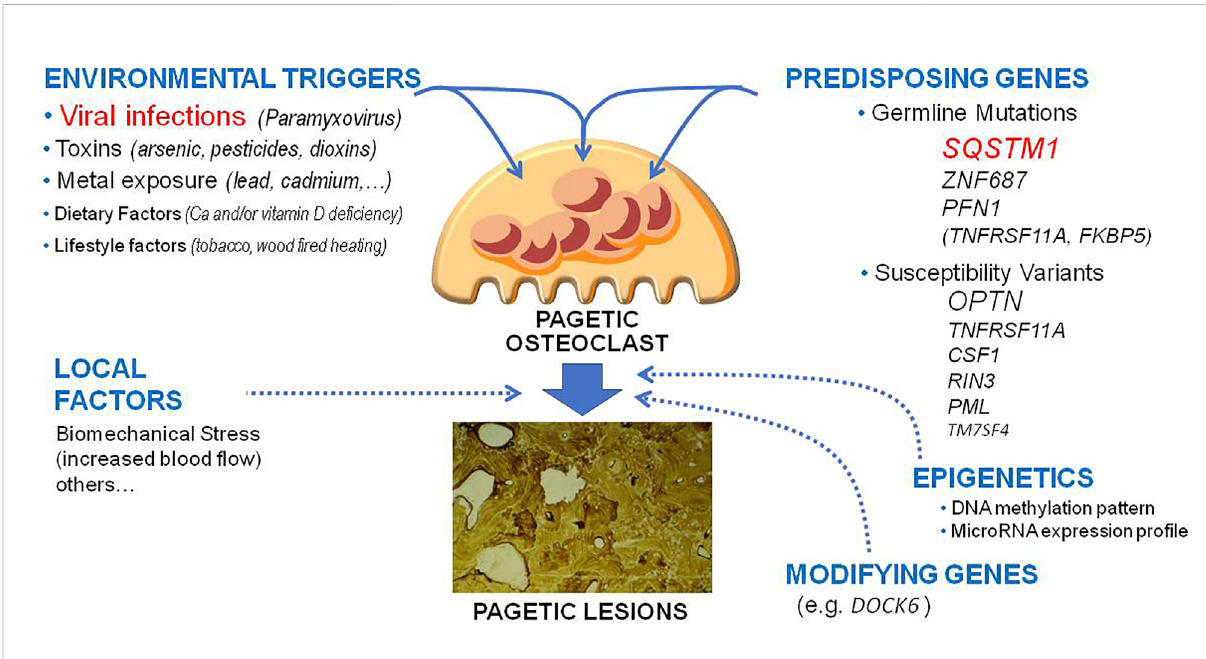
FIGURE 1 Updated pathogenetic model of Paget ’ s disease of bone. The fi gure underlines the different genetic, environmental lifestyle and epigenetic factors and their potential reciprocal interactions in the pathogenesis of pagetic lesions.